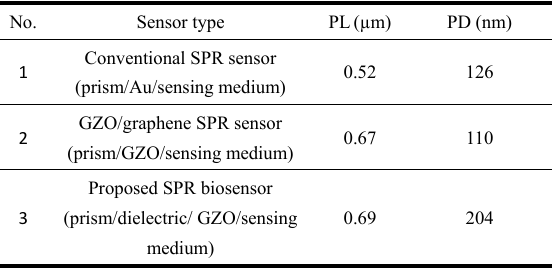
Table 2 PL and PD calculated for the conventional SPR sensor, GZO/graphene SPR, and GZO/graphene SPR with